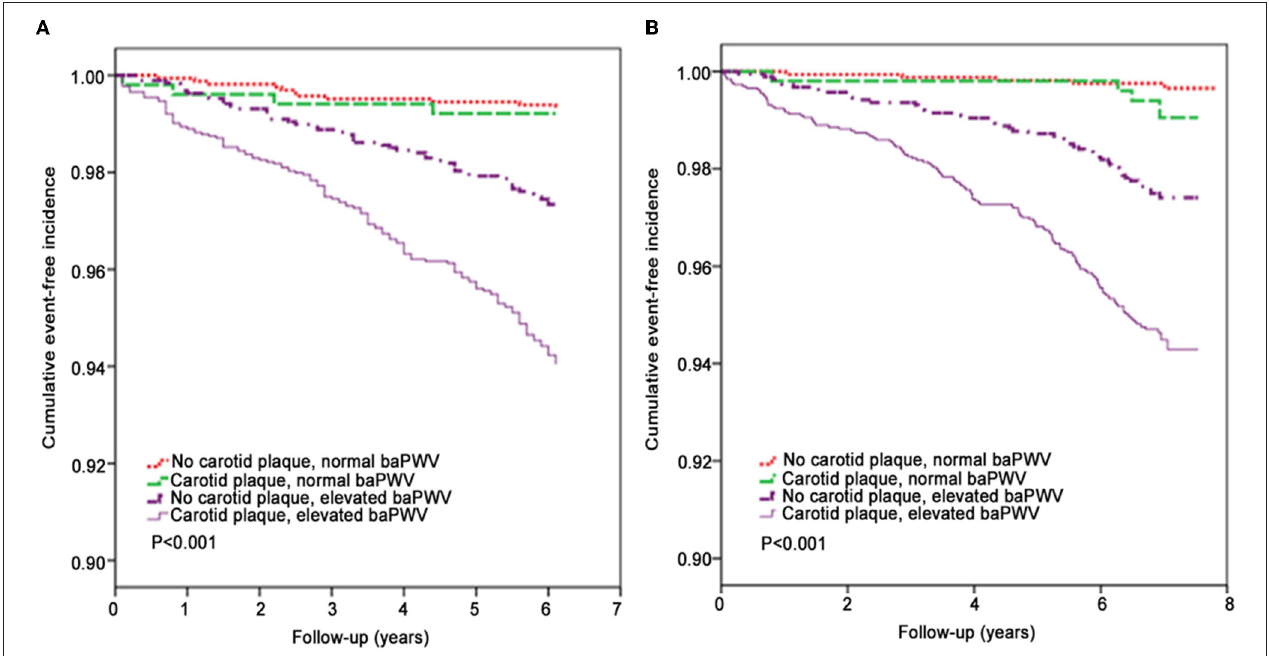
FIGURE 2 | Kaplan-Meier analysis of the effects of carotid plaque and brachial-ankle pulse wave velocity on clinical outcomes. (A) Cardiovascular disease events (CVD, a composite of myocardial infarction and cerebral ischemic stroke). (B) Cerebral ischemic stroke